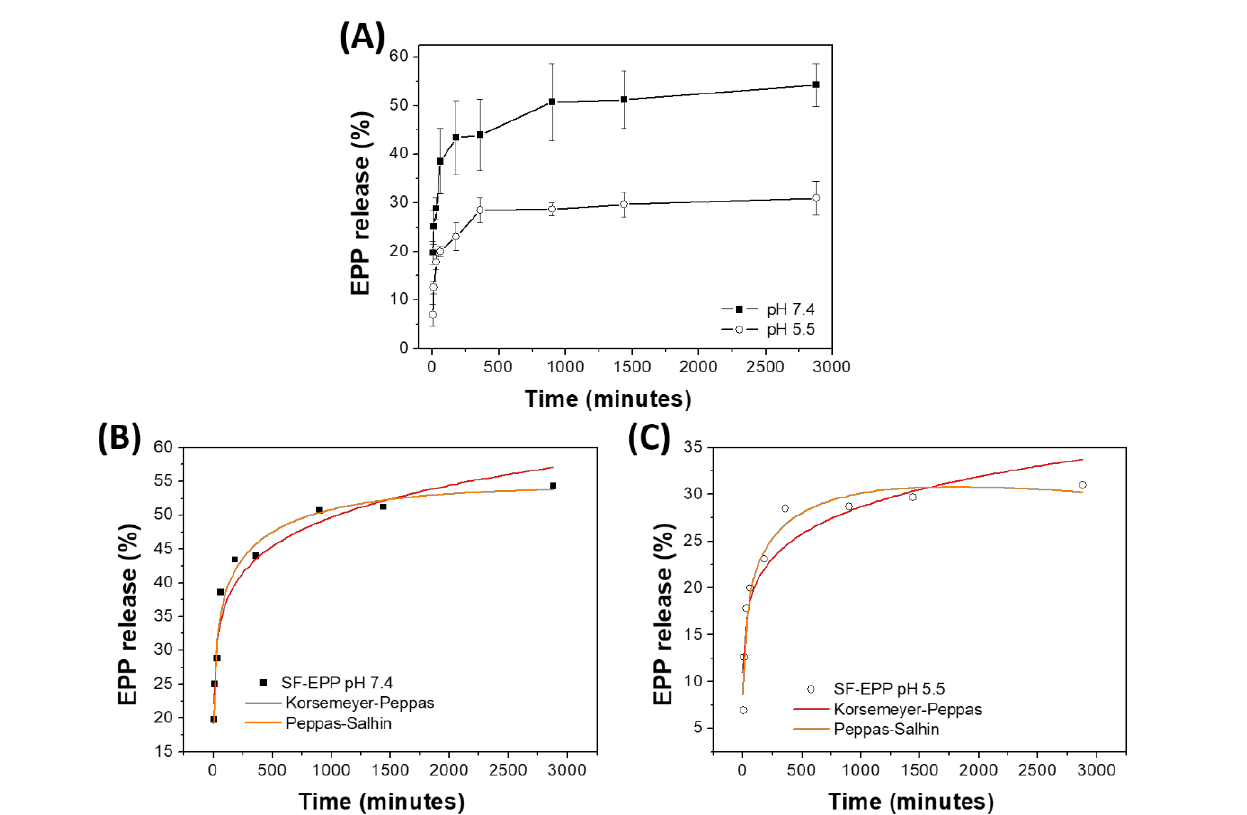
Figure 5. ( A ) EPP release profiles of SF-EPP1.5 at different pHs; ( B , C ) EPP release profiles fitted by Korsemeyer-Peppas and Peppas–Sahlin models for pH 7.4 and 5.5, respectively. Table 3. Parameters and correlation coefficients for Korsmeyer–Peppas and Peppas–Sahlin mod- els.